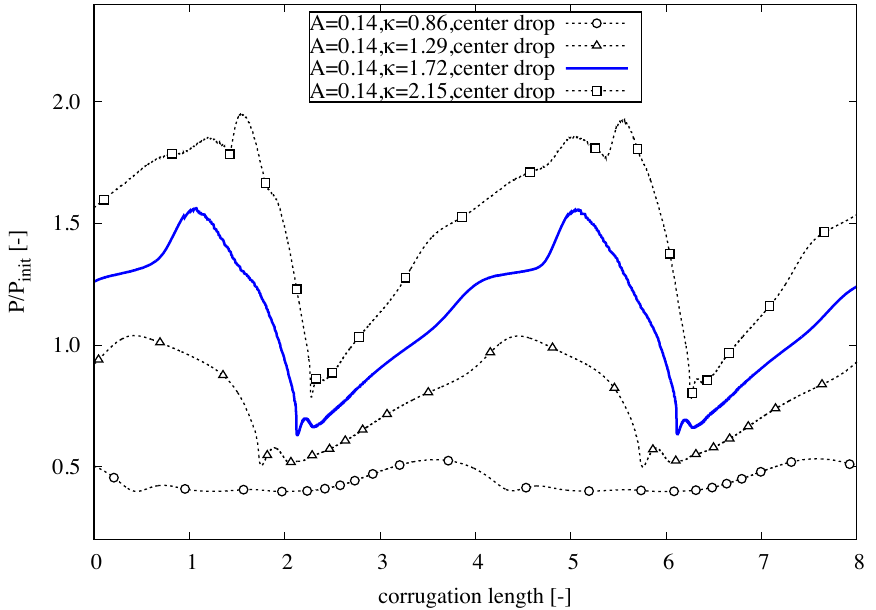
Figure 14. Center drop’s perimeter ratio P/P init within two corrugated lengths for sinusoidal with amplitude A = 0.14, initial slug length s = 1.375 and drop size factor for several drops: κ d = { 0.86,1.29,1.72,2.15 } . As expected, the the larger is the drop’s size factor κ d , the larger is the perimeter ratio variation.